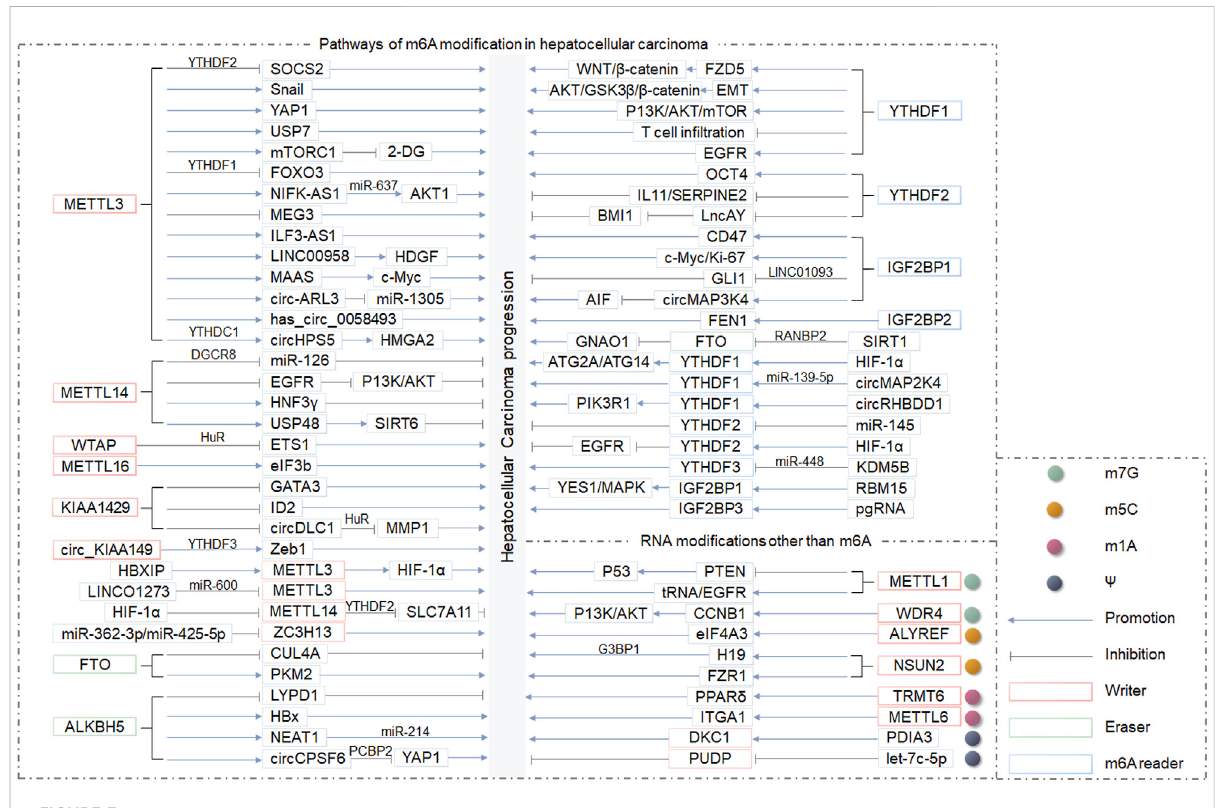
The role of RNA epigenetic modi fi cations in HCC